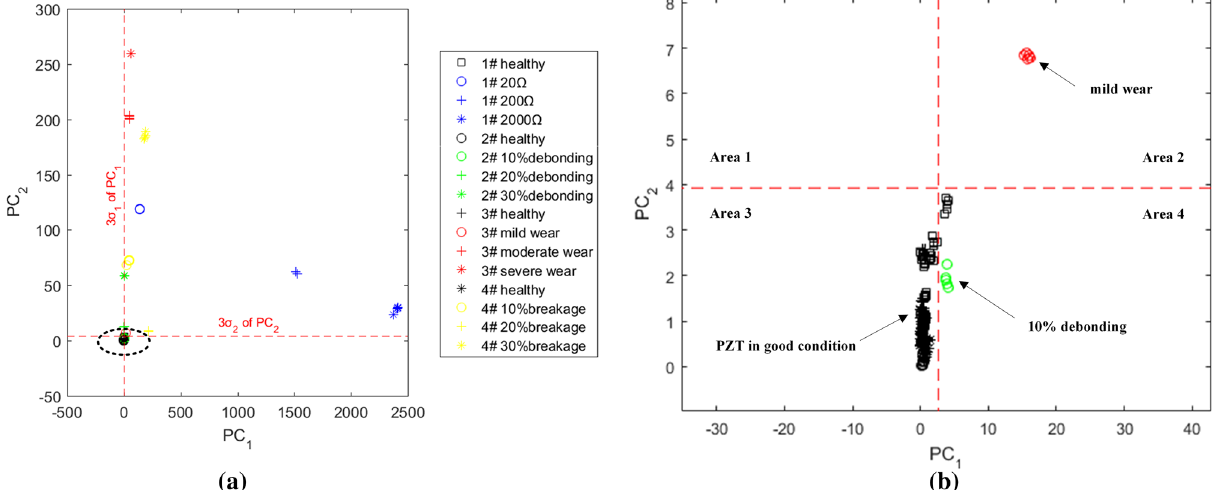
Figure 13. The effect of identification of damaged PZT with principal component analysis ( a ) and enlarged image of the elliptical area surrounded by a dashed line ( b